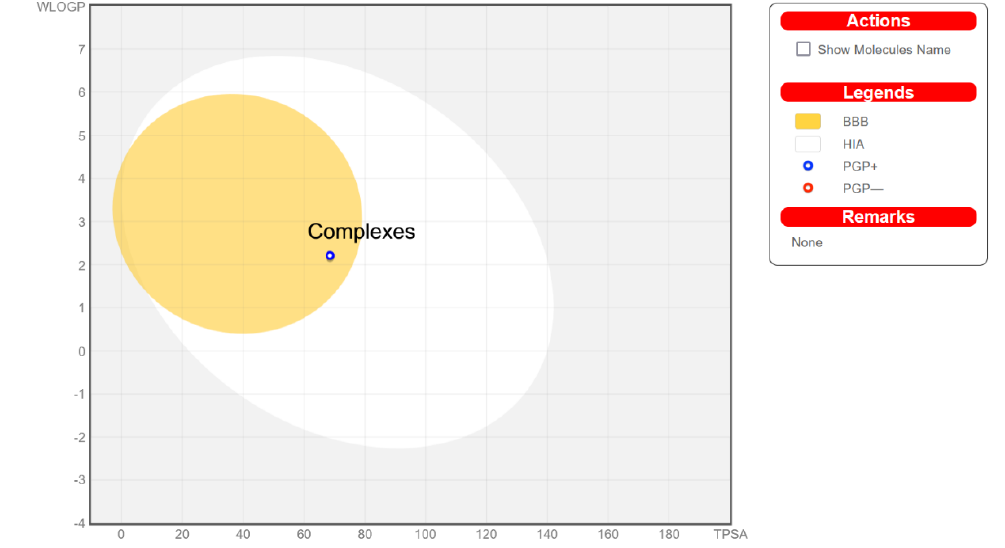
Figure 17. BOILED-Egg diagram for all compounds.